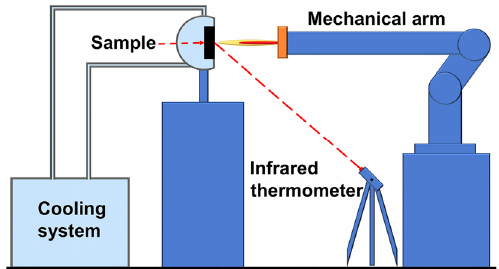
Figure 1. Diagram of air–plasma ablation device.